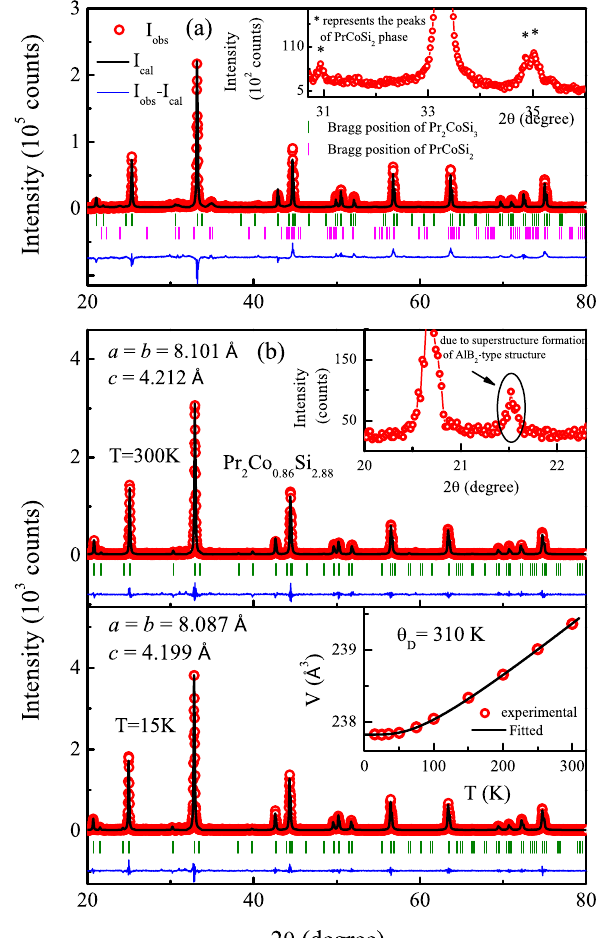
Figure 2. (a) Room temperature XRD pattern of Pr 2 CoSi 3 . Inset of (a) shows the presence of secondary phase PrCoSi 2 in Pr 2 CoSi 3 . (b) The XRD patterns of Pr 2 Co 0.86 Si 2.88 at T = 300 K (top) and T = 15K (bottom) along with full-Rietveld analysis. Inset of (top) presents the major peak associated with the superstructure of AlB 2 -type structure. Inset of (bottom) presents the temperature dependence of unit-cell volume along with fit using Eq. (1). Estimated errors are smaller than the symbol